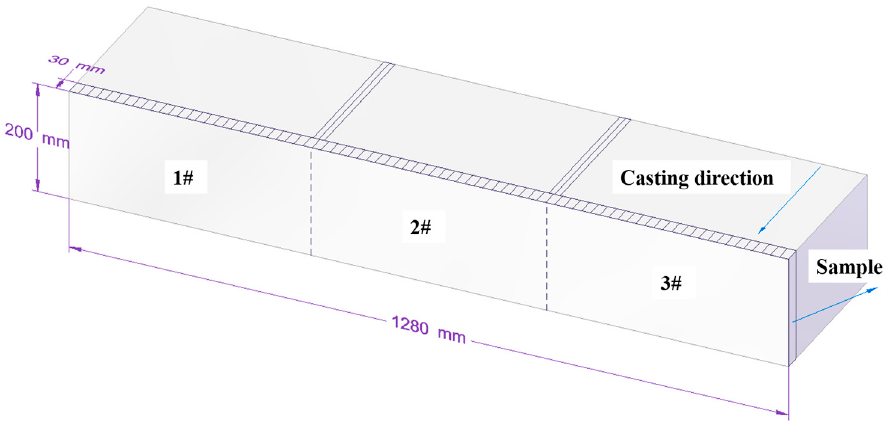
Table 2. Chemical composition of the Fe–17 wt% Cr–0.6 wt% Ni steel used in this study (units: wt%).